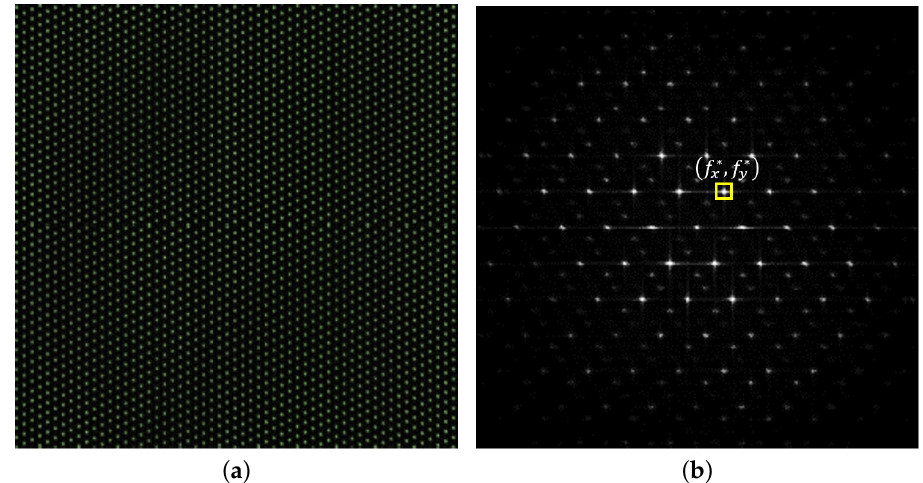
Figure 6. The captured lattice pattern is represented in: ( a ) spatial domain; and ( b ) frequency domain. ∗ ) on the frequency domain is the peak ( f ∗ x , f y